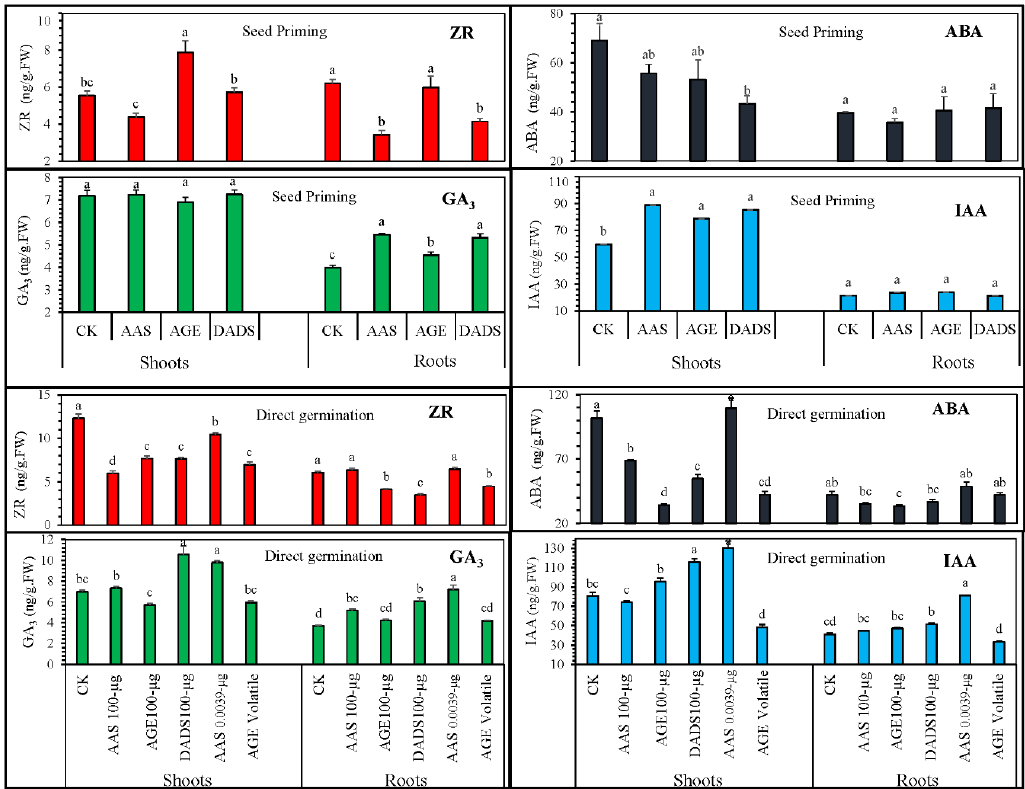
Figure 6. Post-germination phytohormonal regulation in tomato shoots and roots. The endogenous phytohormones auxin (IAA), gibberellic acid (GA 3 ), cytokinin (ZR), and abscisic acid (ABA) are presented. Tomato seeds were germinated after seed priming or, under an allelochemical medium of 100 µg ∙ mL − 1 AGE, 0.29 µg ∙ mL − 1 DADS, or AAS (100 and 0.00039 µg ∙ mL − 1 ). Bars represent means and standard errors after ANOVA and HSD test.